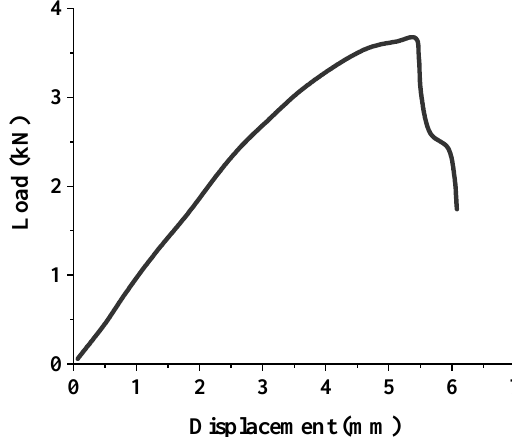
Figure 2. Typical load-displacement curves.